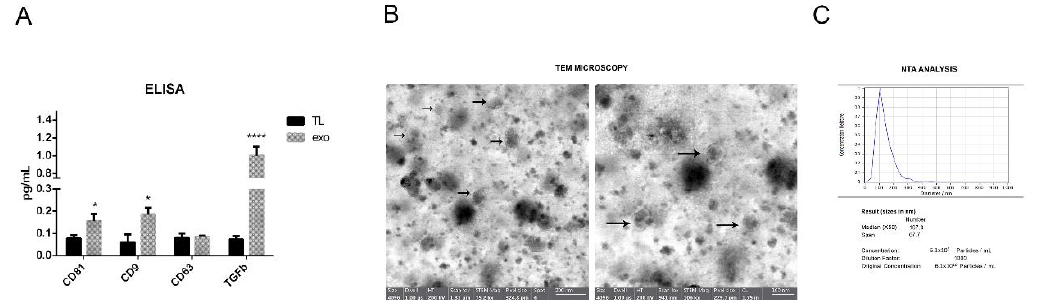
Figure 1. Exosome characteristics. ( A ) ELISA analysis of exo markers and TGFβ1 on the three lysates of isolated exosomes and relative hAFSCs (TL: total lysate). * p -value < 0.05 (CD81 p = 0.041; CD9 p = 0.039); **** p -value < 0.0001 for TGF β1 . ( B ) Representative images of transmission electron microscopy (TEM) shown at different magnifications. Arrows indicate vesicles. ( C ) Representative nanoparticle tracking analysis (NTA) performed on exosome suspension with ZetaView.